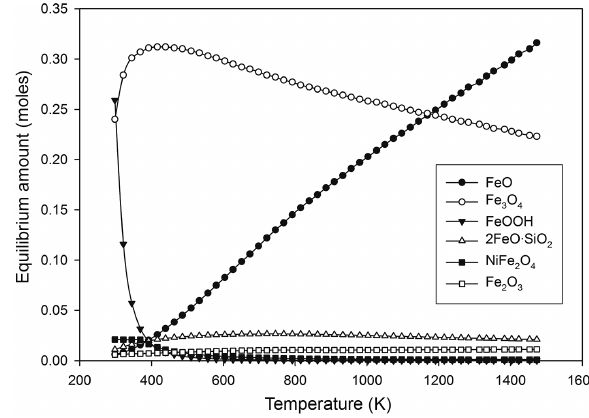
Figure 5: Effect of temperature on the amounts of the iron oxide- containing species for reduction of the ore in hydrogen at a reduc- tant to ore ratio of 0.558 kmol/100 kg.